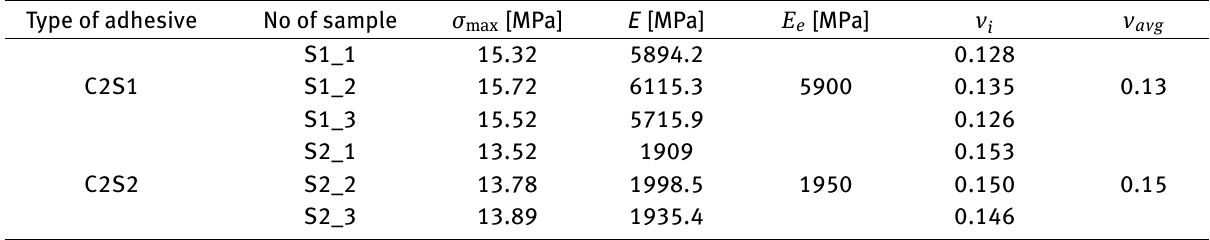
Table 1: Average value of the Young modulus and Poisson factor in the adhesive tested. Type of